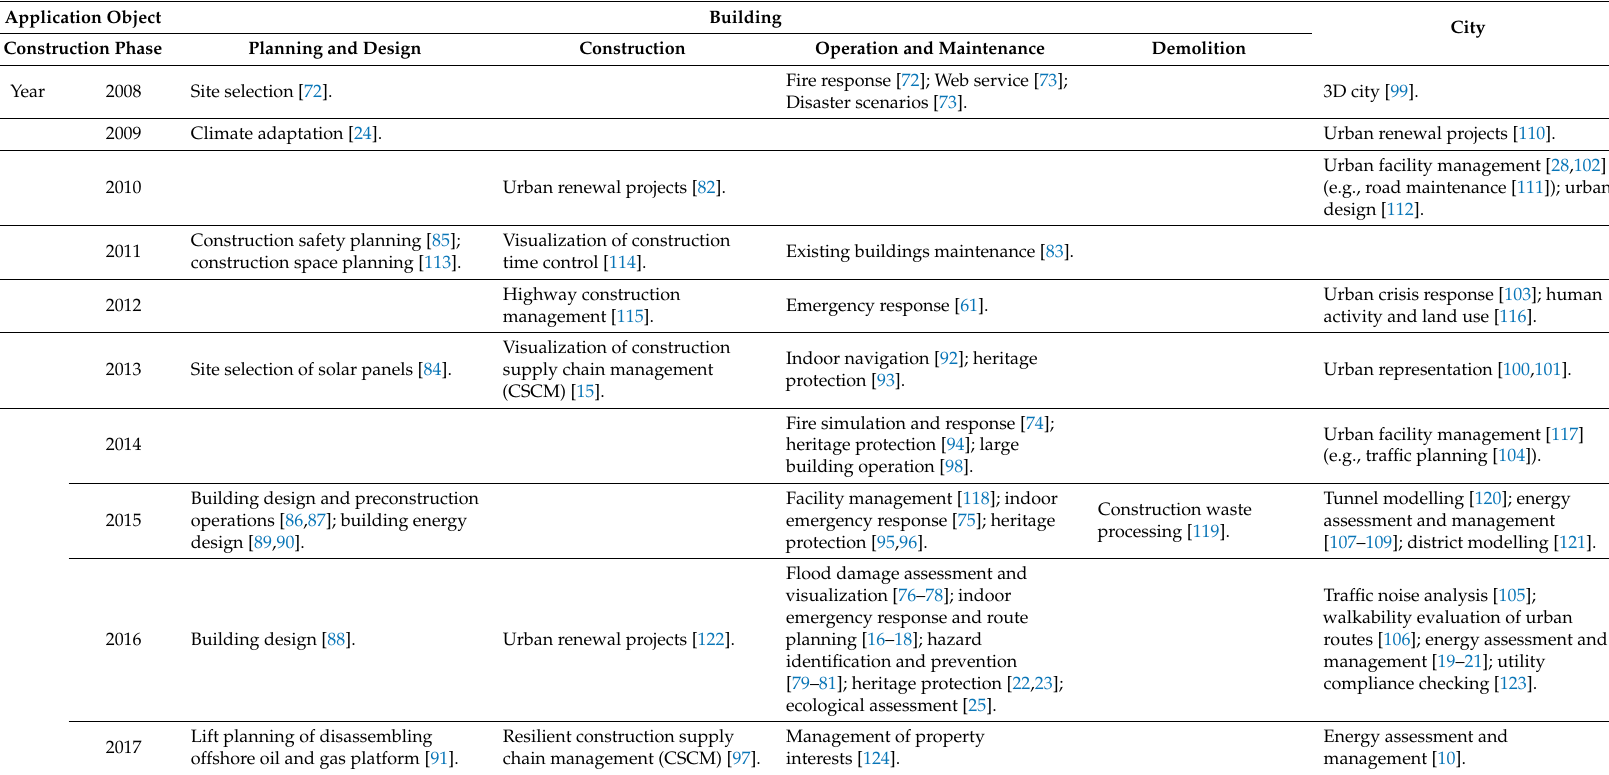
Table 3. Application evolution of BIM-GIS integration in the Architecture, Engineering and Construction (AEC)